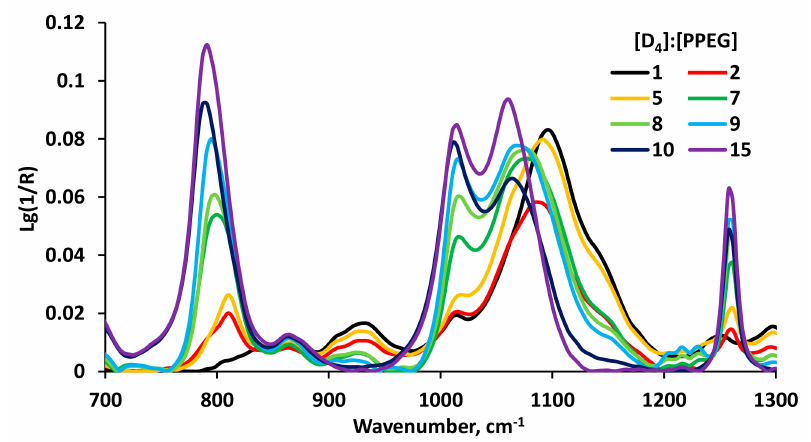
Figure 3. FTIR spectra of multiblock copolymer (MBC) obtained on the molar excess of D 4